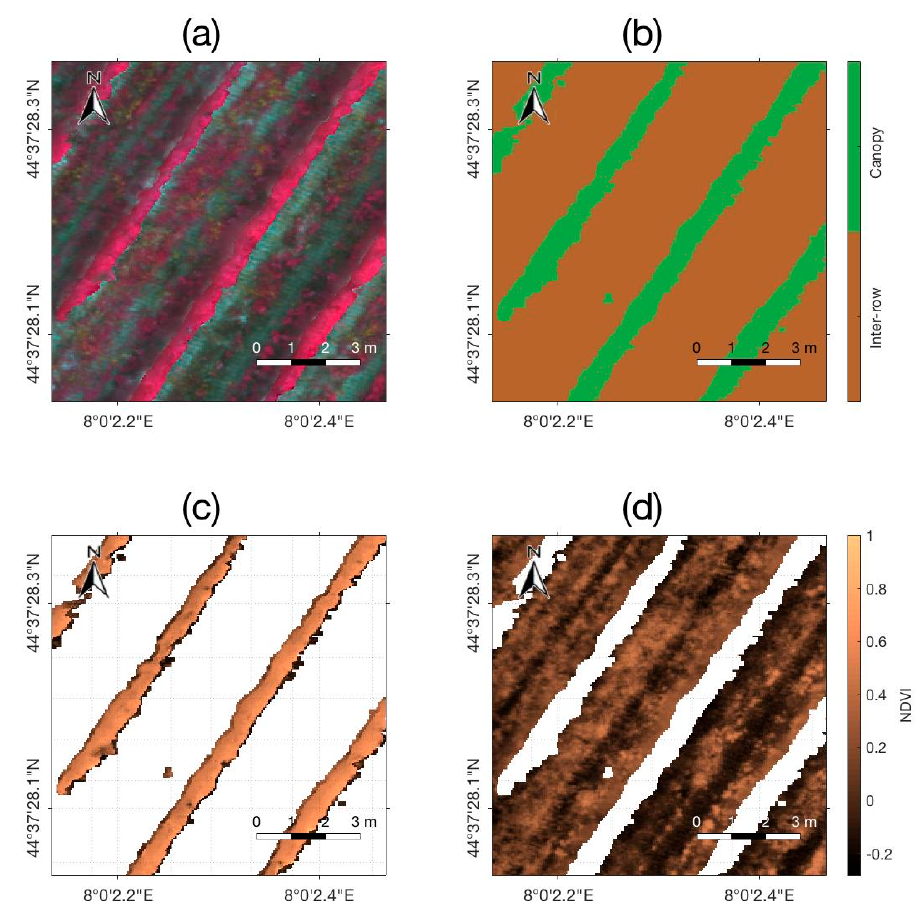
Figure 5. ( a ) Enlargement of subset 𝒢(8,20) of UAV map 𝒟 (cid:2870) , highlighted by a yellow square in Figure 1, is represented in false colours (NIR, Red and Green channels); ( b ) classification of pixels 𝑑(u,v) ⊂ 𝒢(8,20) into two classes: 𝒢 (cid:2932)(cid:2919)(cid:2924) , representing vine canopies (green), and 𝒢 (cid:2919)(cid:2924)(cid:2930) , representing inter-row surfaces (brown); ( c ) computed NDVI values of vine canopies pixels 𝒢 (cid:2932)(cid:2919)(cid:2924) ; and ( d ) inter-row surface 𝒢 (cid:2919)(cid:2924)(cid:2930)